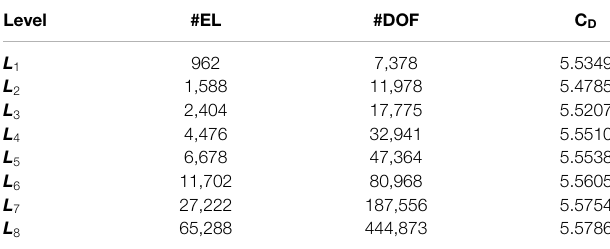
TABLE 1 | Degrees of freedom and grid convergence for various